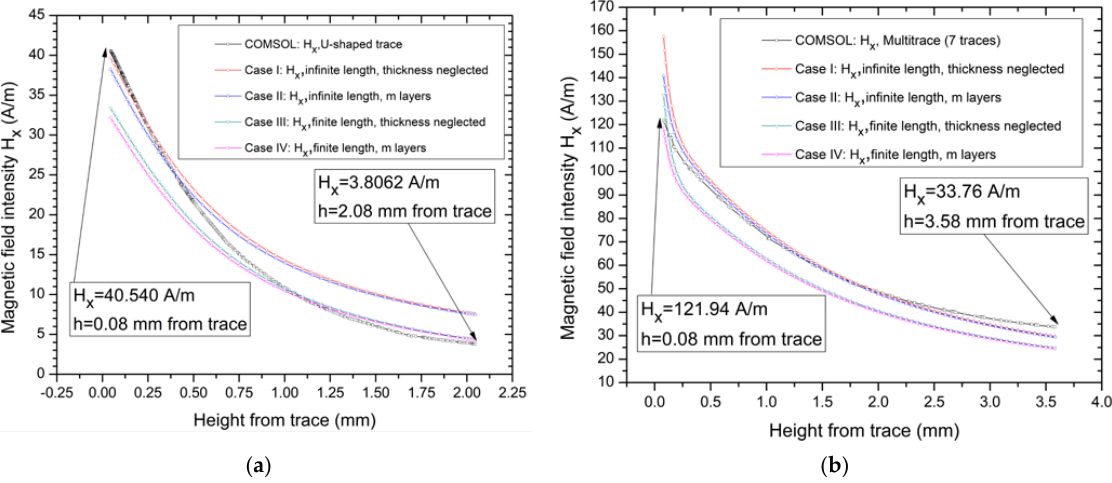
Figure 20. ( a ) Magnetic field intensity H x , variation for different h (0.08 mm to 2.08 mm) for the “U-shaped current trace according to results from COMSOL simulation and from the analytical model; ( b ) Magnetic field intensity H x , variation for different h (0.08 mm to 3.58 mm) for the “Planar coil with 7 traces” according to results from COMSOL simulation and from the analytical model; The current through the trace was 100 mA. Table 2. Comparative analysis between COMSOL simulation, analytical model, and experimental